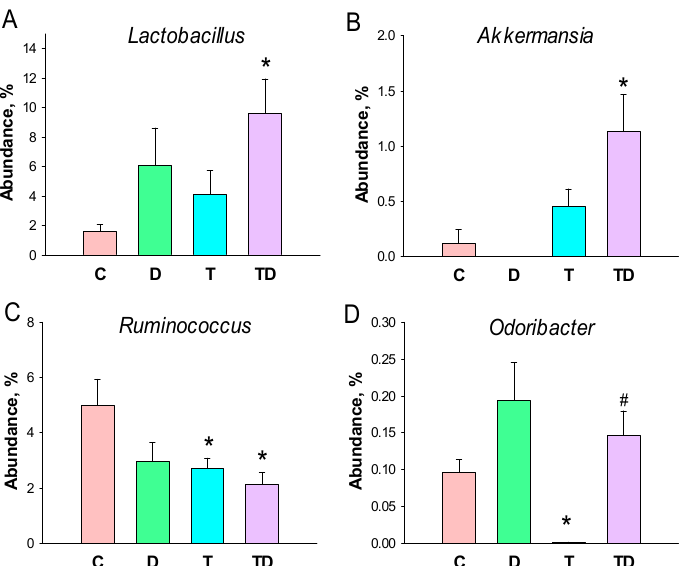
Figure 5. Effect of 3,3-Dimethyl-1-butanol (D) and 2,3,7,8-tetrachlorodibenzo-p-dioxin (T) on the gut microbiome in offspring. Relative abundance of the genera ( A ) Lactobacillus , ( B ) Akkermansia , ( C ) Ruminococcus , and ( D ) Odoribacter . N = 8 per group; * p < 0.05 vs. C; # p < 0.05 vs. T. Figure 6 shows statistically significant microbial markers between groups, which were identified by the LEfSe analysis. There was a greater abundance of genera Blautia, Akkermansia, and Collinsella ; whereas a lower abundance of Roseburia, Alistipes , and Odori- bacter in the T group vs. the C group (Figure 6A). Figure 6B shows TD group had a greater genus level abundance of Lactobacillus and Odoribacter than that in the T group.